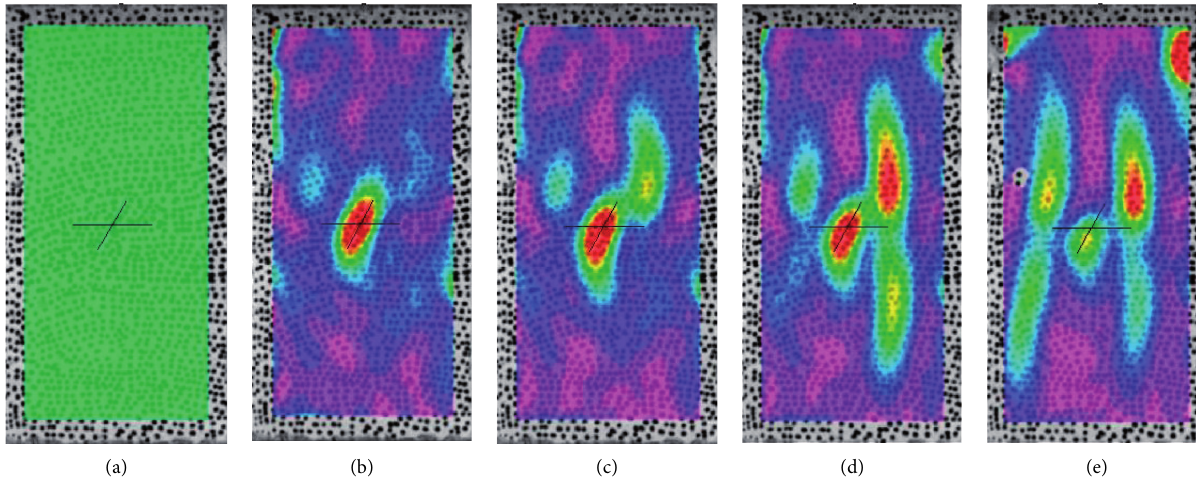
Figure 14: Stress field developed at different times for the jointed specimen with α � 60 ° . (a) t � 0s. (b) t � 180s. (c) t � 525s. (d) t � 655s. (e) t �